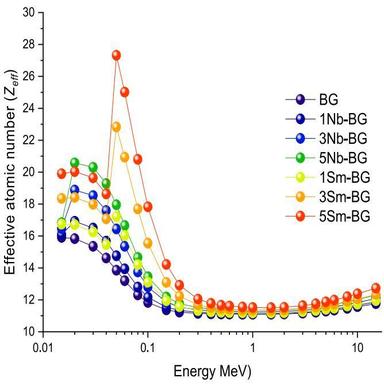
Variation of effective atomic number (eff) as a function of increasing energy.